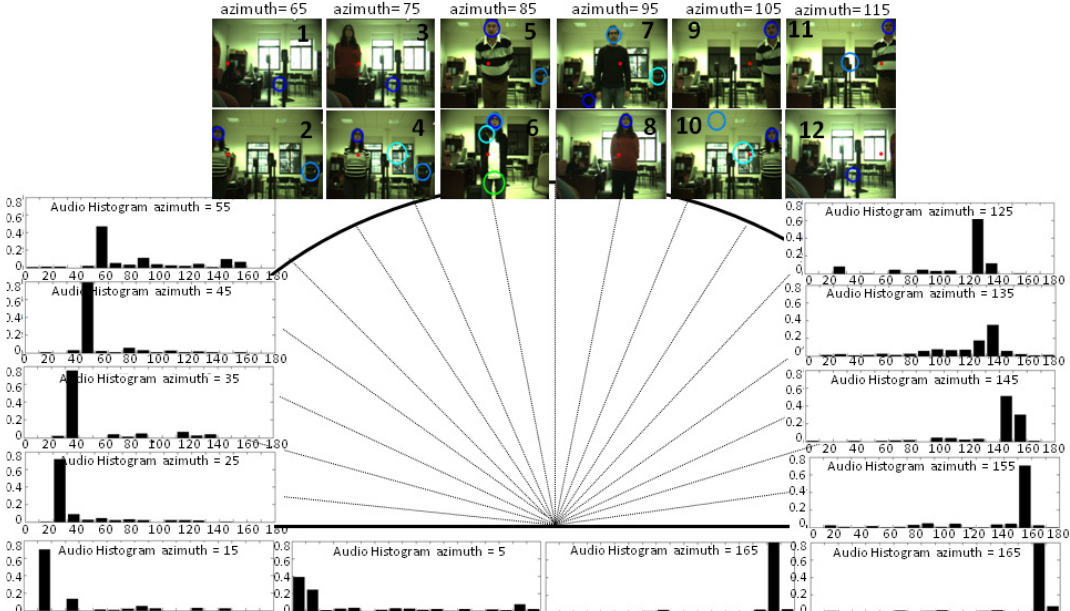
Figure 7. The results obtained with different speakers and noise source conditions while tracking a speaker with the audio localization system. The histograms show the evidence encountered for each detection of 1 s in the 12 angles out of the camera field of view. The images show with a red circle the audio system estimation made within the field of view area. Blue circumferences show OpenCV face-detector